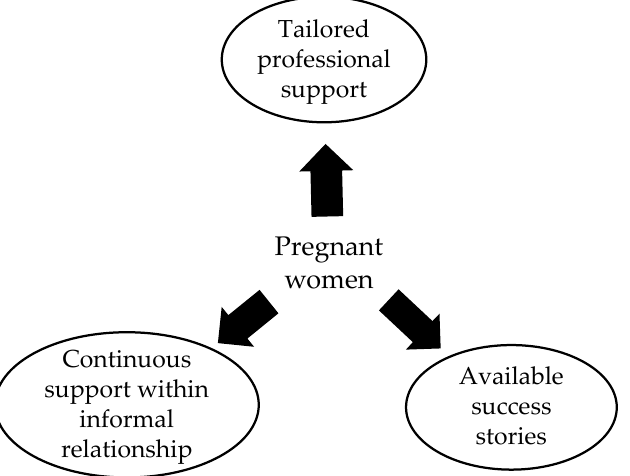
Figure 1. Needs of support for anxiety during pregnancy. White circles: type of support; Black arrows: needs.